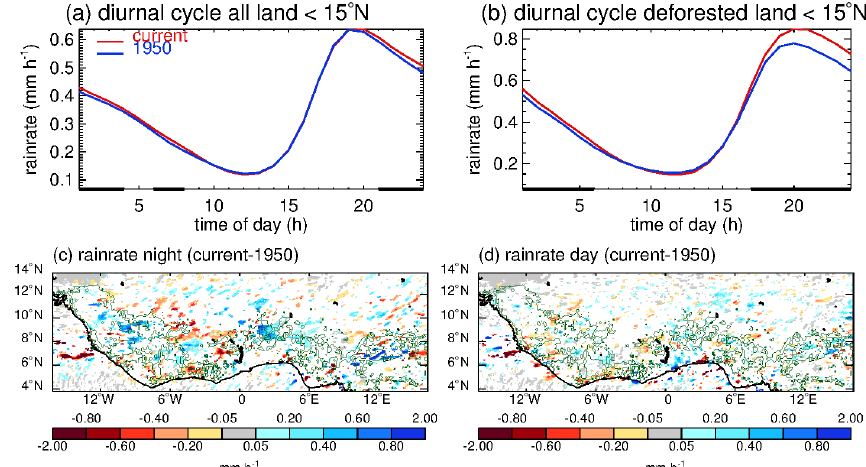
Figure 7. Diurnal cycle of rainfall with times where differences are significant at p = 0.1 indicated by black bar for (a) all land points below 15 ◦ N and (b) deforested pixels only. Maps of rainfall differences for (c) 19:00–06:00UTC and (d) 07:00–18:00UTC. Insignificant changes at the individual pixel level are shown in white, whereas small but significant changes either side of zero are shown in grey. Green contours show where there has been